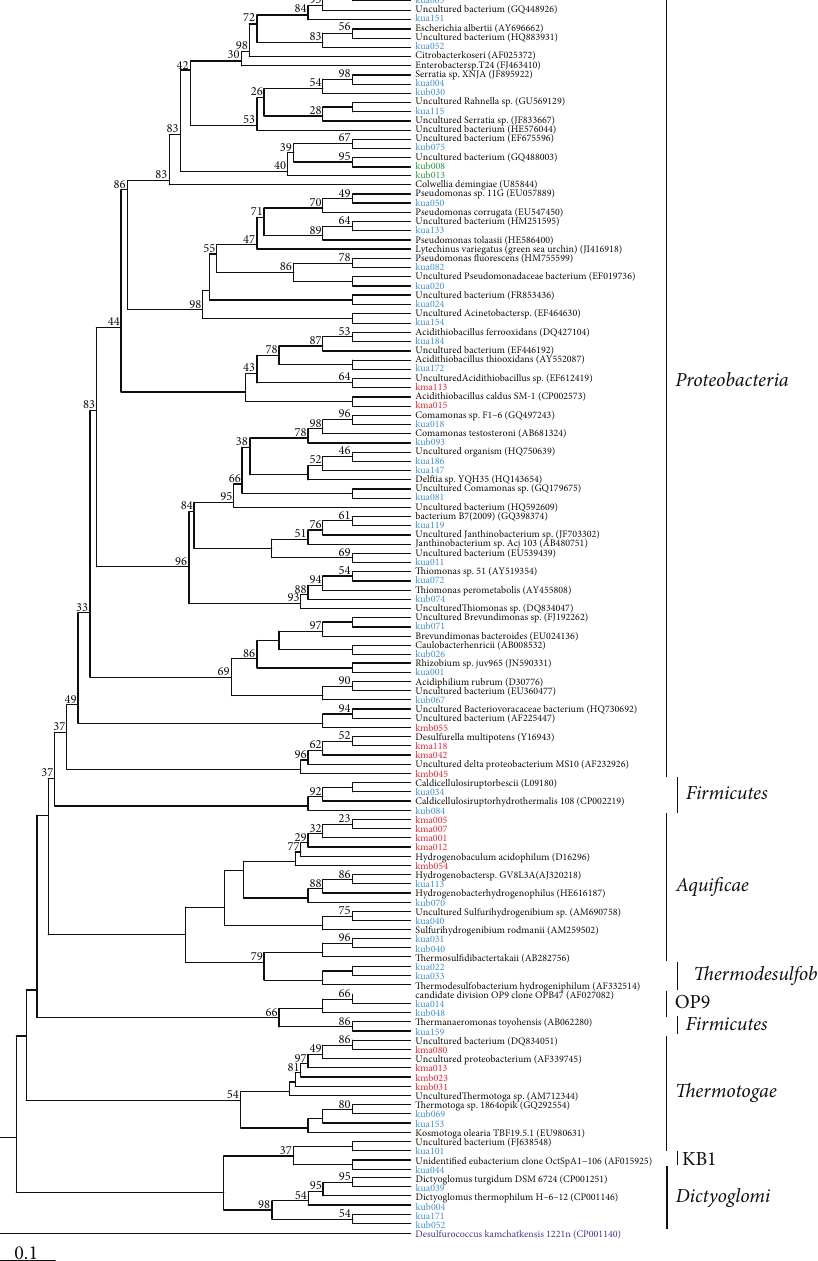
Figure 3: Maximum parsimony phylogenetic tree based on all bacterial 16S rRNA gene sequences. The tree was calculated using the ARB software package [33]. Sequences are characterized by sample designation (km, Kamchatka Mutnovsky; ku, Kamchatka Uzon Caldera), length of amplicon ((a), 1100 bp, (b), 730 bp), number of sequence, and accession number. Sequences derived from the Mutnovsky are shown in red and those from the Uzon Caldera in blue. OTUs shared by both sites are depicted in green. Numbers at branch nodes are bootstrap values (only values ≥ 25 are shown). The tree is rooted with the 16S rRNA gene sequence of Desulfurococcus kamchatkensis 1221n as an outgroup